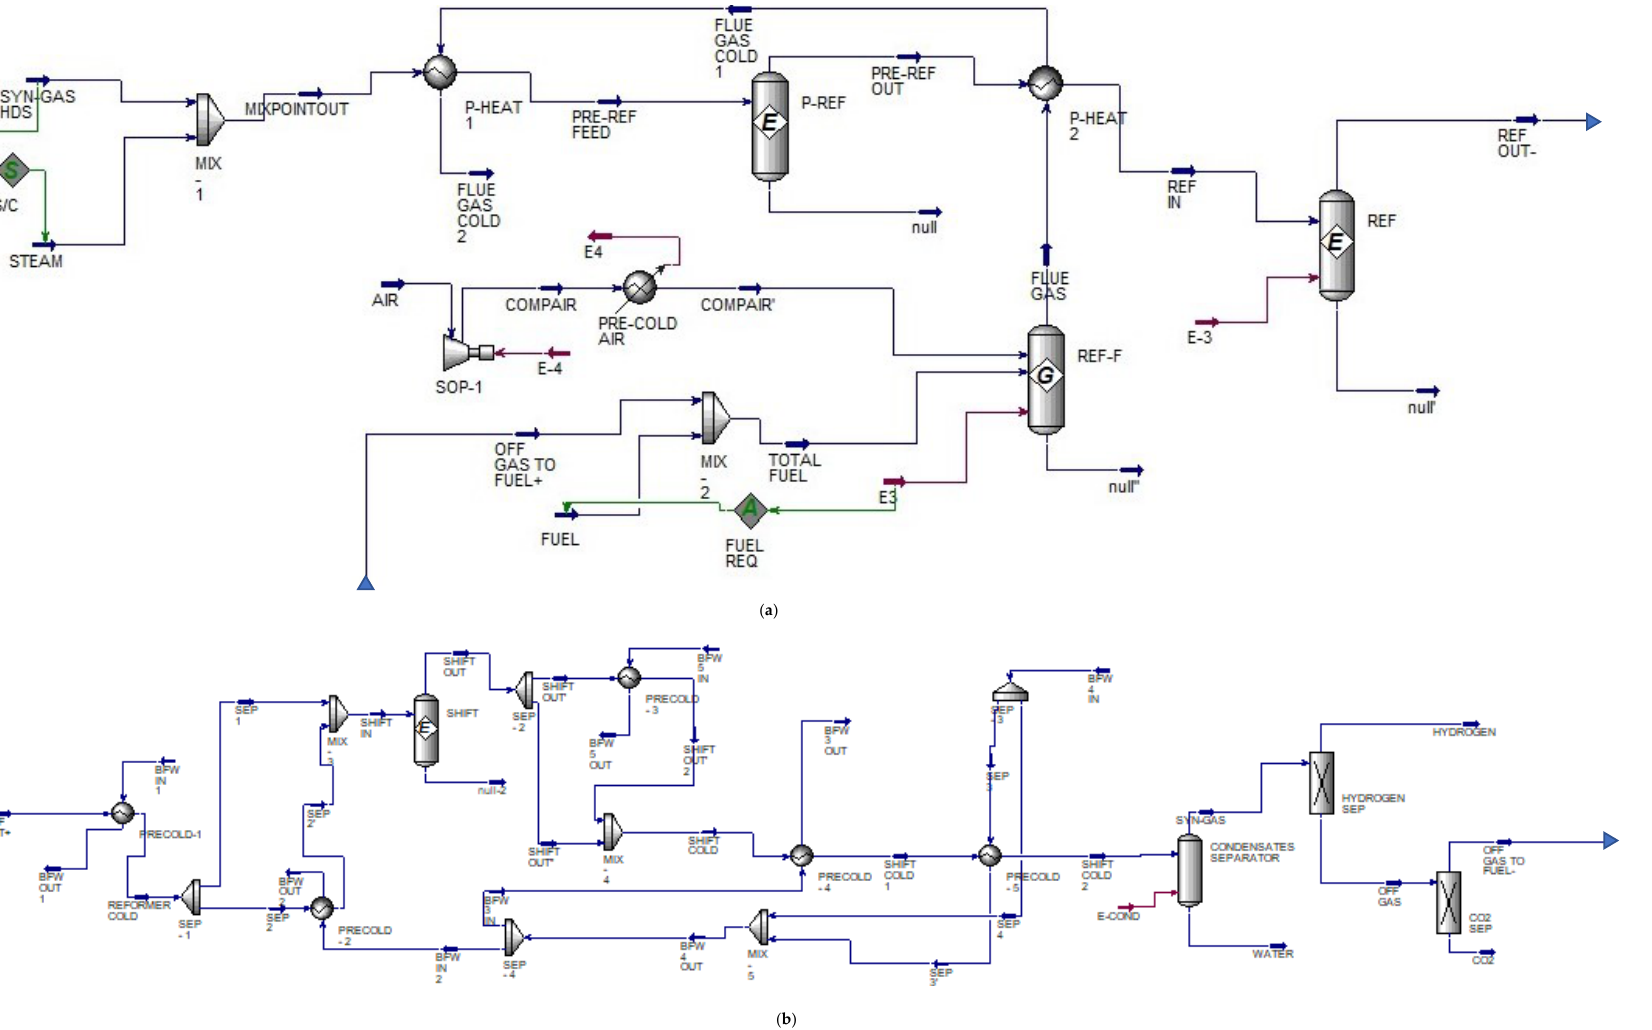
Figure 1. ( a ) Section 1—reformer section Aspen HYSYS ® process flow diagram; ( b ) Section 2—shift section Aspen HYSYS ® process flow diagram.